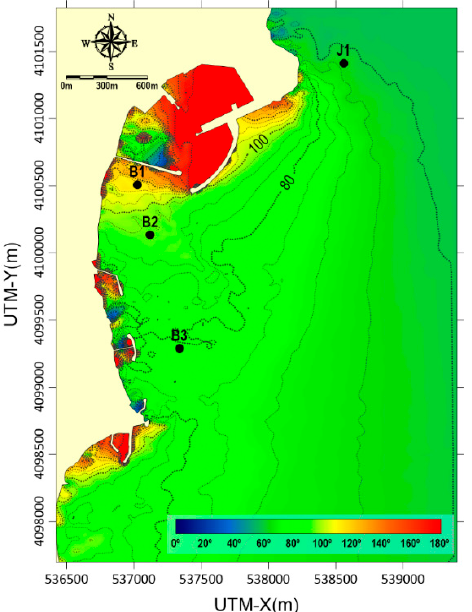
Figure 10. Distribution of the wave propagating direction, D m , modeled by TEL EMAC– TOMAWAC, Case 2. Table 3. List of wave parameters calculated from the model results, Case 2. The percentages in the parenthesis are the model errors from the observations.